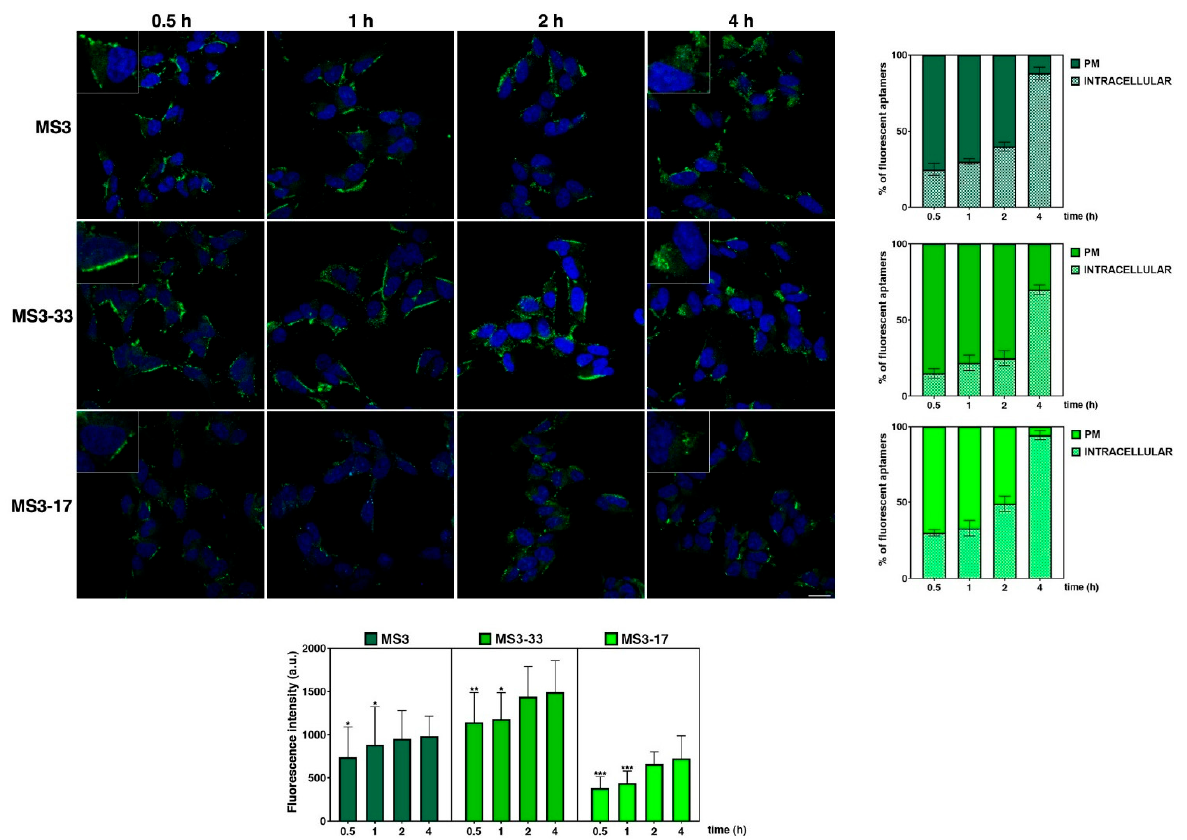
Figure 8. Time-course analysis of cell uptake of MS3 and its analogues. SH-SY5Y cells were incubated with a 4 µ M solution of FITC-conjugated aptamers (green) at the indicated time points and fixed; then, nuclei were stained with DAPI (blue). Images were acquired with a confocal microscope. Higher magnification pictures in the insets. Scale bar, 6 µ m. Mean fluorescence intensity of two independent experiments is shown, n > 50 cells; error bars, mean ± SD. *** p < 0.001, ** p < 0.01, * p < 0.05, Bonferroni test after significant ANOVA. Mean fluorescence intensities at the plasma membrane (PM) or inside the cell (intracellular) were measured at the different times and expressed as percentage of total fluorescence; n > 30 cells.